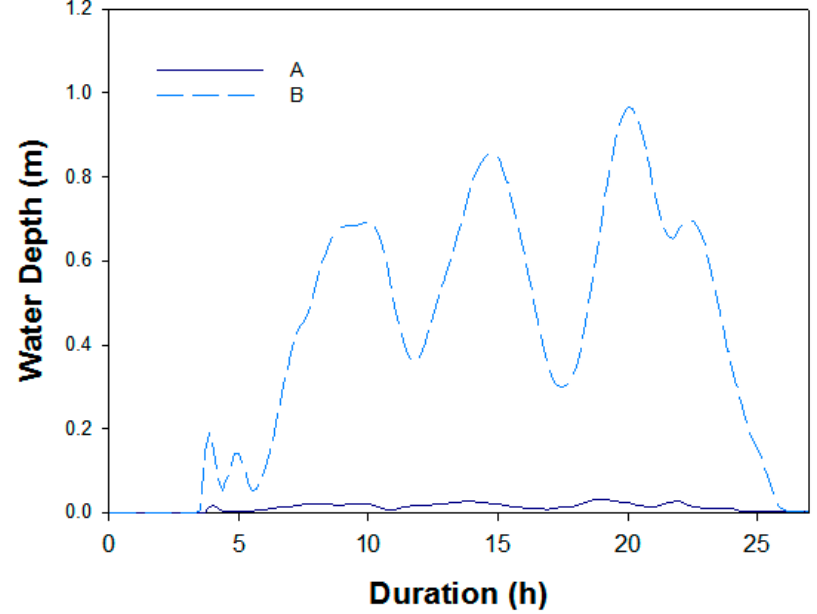
Figure 7. Simulation results of water depth on slope surface at Locations A and B during Typhoon Meigi.